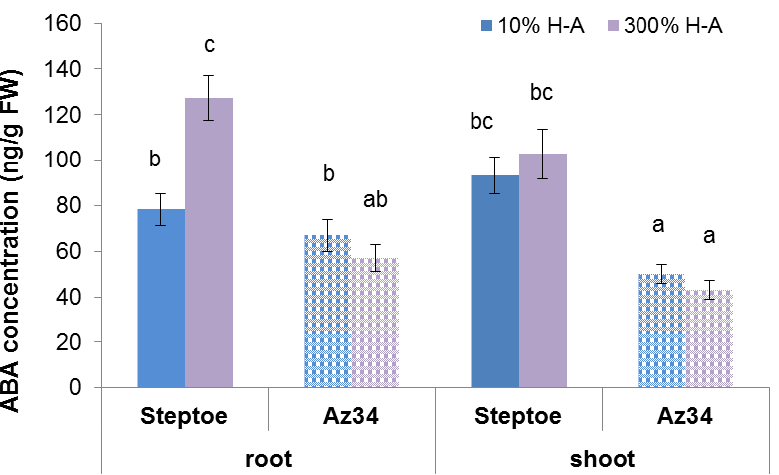
Figure 6. Concentration of ABA in roots and shoots of 6-day-old barley wild type (Steptoe) and its ABA-deficient mutant (Az34) growing at 10% of supra-optimal (300%) Hoagland-Arnon solution (H-A). Means ± SE are presented. Statistically different means (n = 9) are indicated by different letters ( p < 0.05, ANOVA, Duncan’s test).